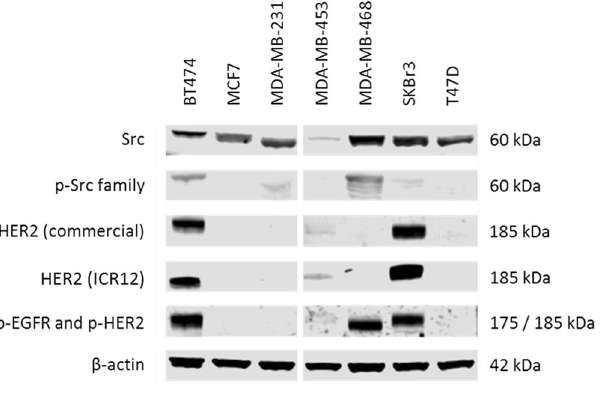
Figure 6. Western blot analysis of tyrosine kinase expression and phosphorylation in untreated breast cancer cell lines. Cell lines were grown to near-confluence in 10% FBS DMEM, washed in PBS and lysed. Proteins were separated using SDS-page electrophoresis, transferred to PVDF membrane and probed with antibodies targeting proteins of interest, including Src, phospho-Src, HER2 and phospho-HER2. The commercial anti-HER2 antibody (Cell Signaling Technology Inc) targeted the intercellular domain of HER2, while our in-house developed anti-HER2 antibody ICR12.27 targeted the extracellular domain. Negligible differences were observed between these two. Phospho-EGFR and phospho-HER2 were detected using the phospho-Src antibody, which had specific cross-reactivity with phosphorylated receptor tyrosine kinases.